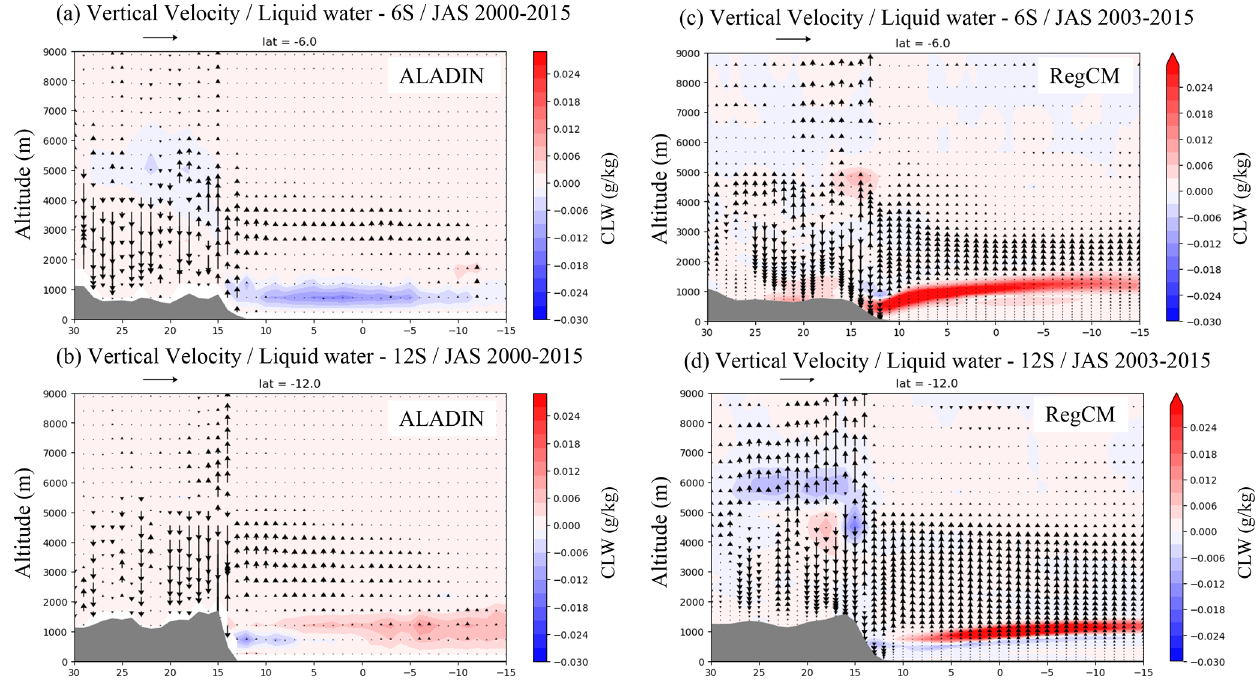
Figure 12. Seasonal-mean (JAS) changes (SMK minus CTL simulations) in the vertical profiles of the vertical velocity (arrow) and cloud liquid water content (in grams per kilogram) for ALADIN ( a, b , period 2000–2015) and RegCM ( c, d , period